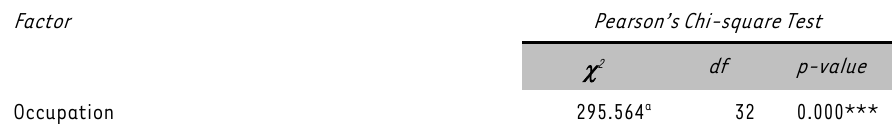
TABLE 7: Analysis of effect of occupational status on household net equity quintile